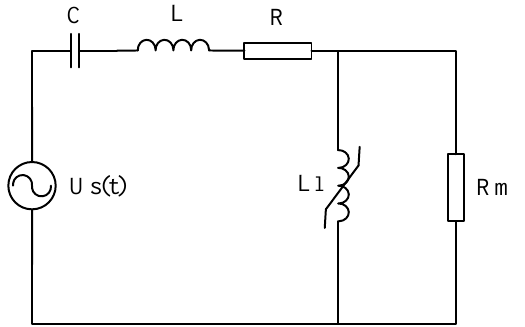
Figure 2. Simplified equivalent schematic diagram of CVT.